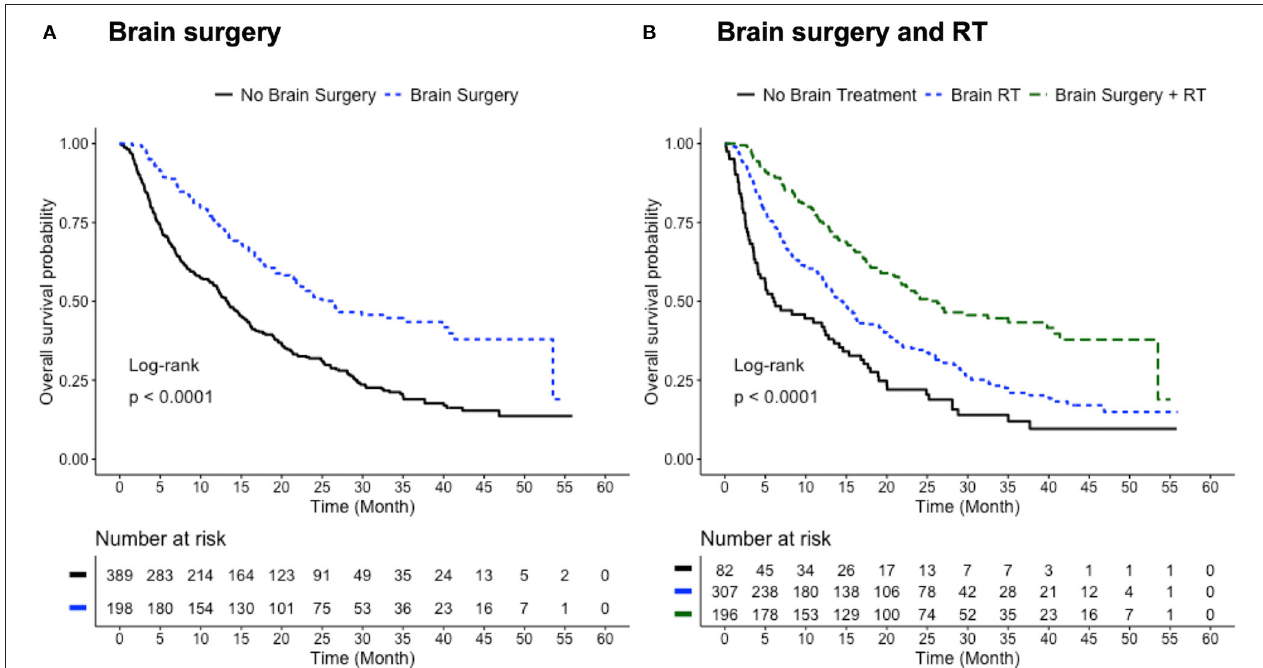
FIGURE 2 | Benefit of brain treatments. (A) Survival curves for patients with (blue) and without (black) brain surgery. Median survival time: 26.2 months for Brain Surgery group; 13.3 months for No Brain Surgery group ( p < 0.0001, log-rank test). (B) Survival curves for patients who received, in addition to lung surgery, brain surgery and RT (green), brain RT alone (blue), and no brain treatment (black). Median survival time: 26.25 months for Brain Surgery + RT group; 14.49 months for Brain RT group; 6.05 months for No Brain Treatment group. Three group comparison: log-rank test p < 0.0001. Pair-wise log-rank test: p < 0.0001 for Brain Surgery + RT vs. Brain RT; p < 0.0001 for Brain Surgery + RT vs. No Brain Treatment; p < 0.001 for Brain RT vs. No Brain Treatment. Number of patients with available survival data: n = 198 in Brain Surgery group; n = 389 in No Brain Surgery group; n = 196 in Brain Surgery + RT group; n = 307 in Brain RT group; n = 82 in No Brain Treatment